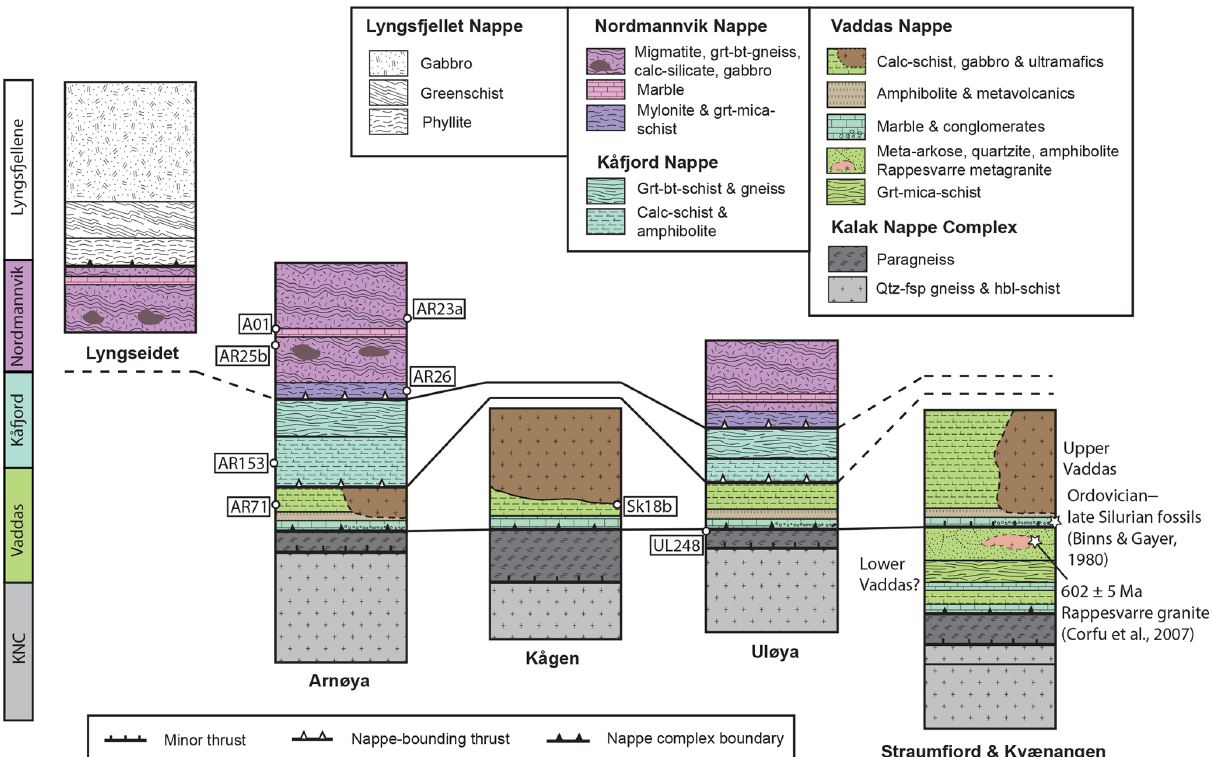
Figure 3. Representative tectonostratigraphy of the RNC from Lyngseidet (west) to Straumfjord and Kvænangen (east) showing the location of major structures and relative thickness and spatial variation in tectonic units. Based on Zwaan (1988), Lindahl et al. (2005), and own work. The tectonostratigraphic position of the investigated samples is